Question: What style of plot is this figure drawn as?
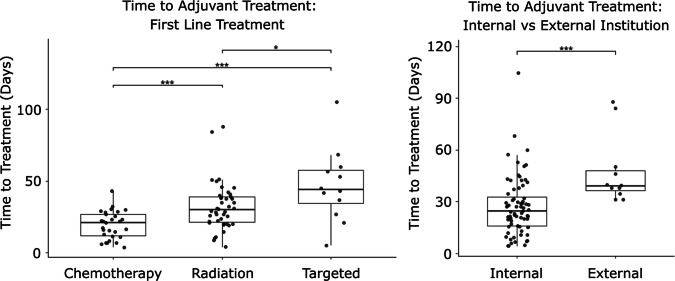
Answer: box